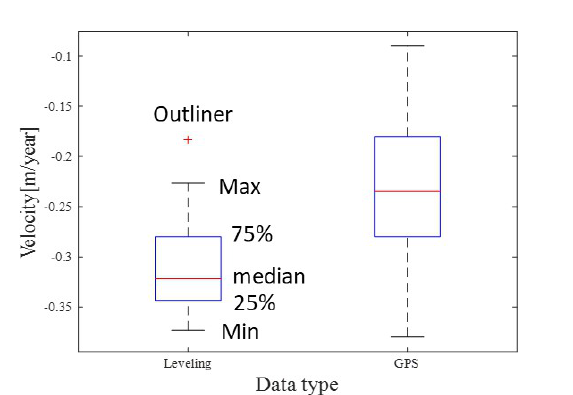
Figure 3. Box plot of vertical velocity difference between GPS and